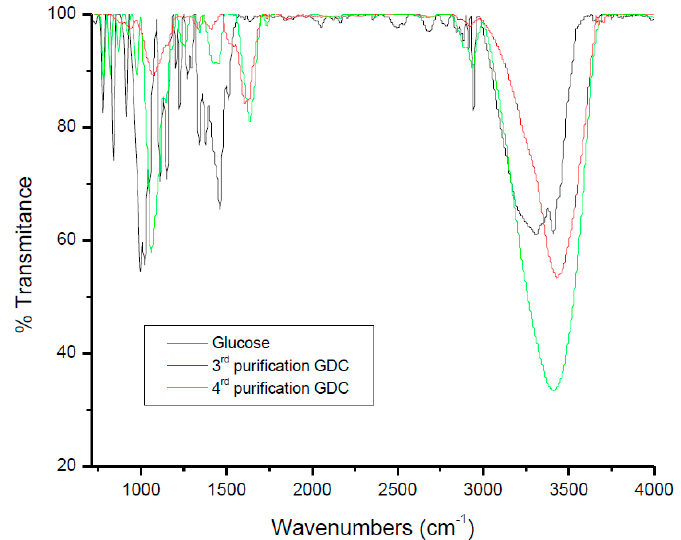
Figure 4. FT-IR spectra of glucose and enriched fractions of the glucose derived chromophore (GDC) purified three and four times consecutively by means of Sephadex LH-20.